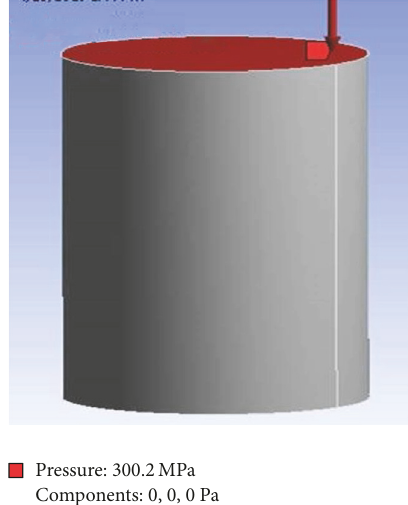
Figure 18: Applied pressure on crusher.